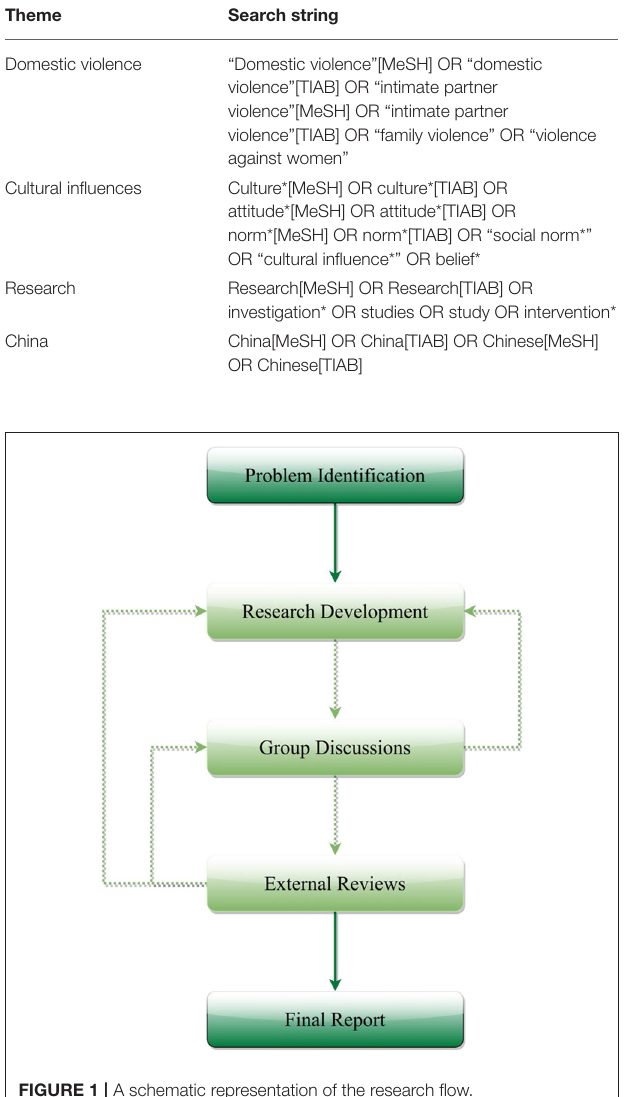
TABLE 1 | Example PubMed search strings.